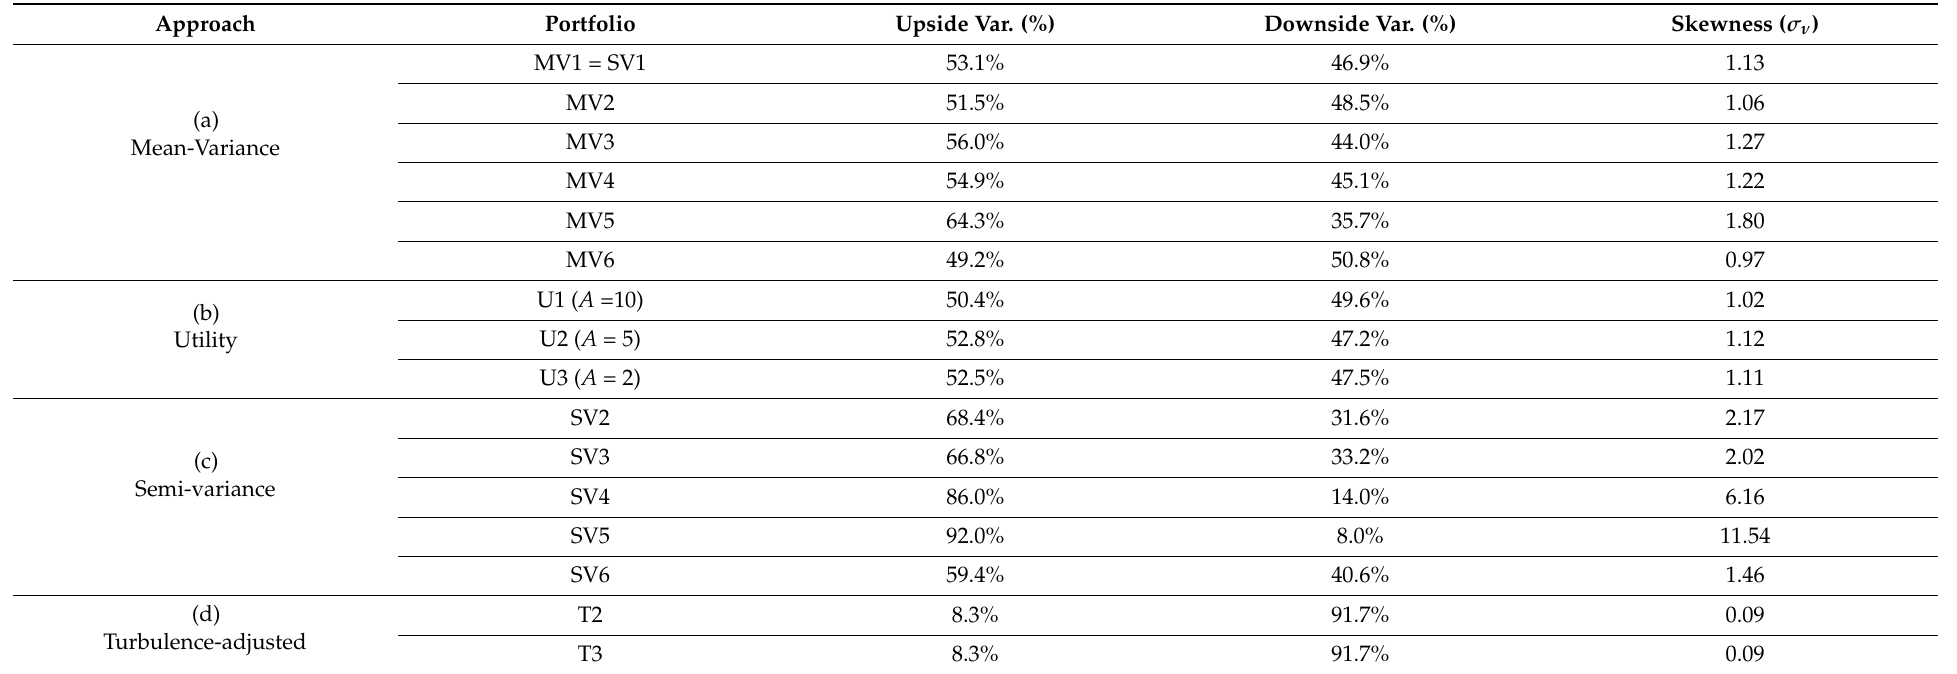
Table 4. Upside/downside variance